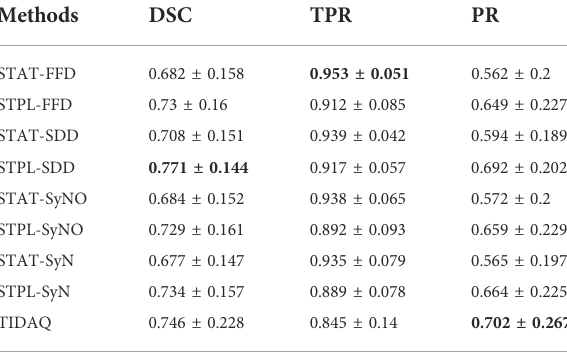
TABLE 6 66% SAT Segmentation Performance (mean ± standard deviation). DSC: Dice Similarity Coef fi cient, TPR: True Positive Rate, PR: Precision.